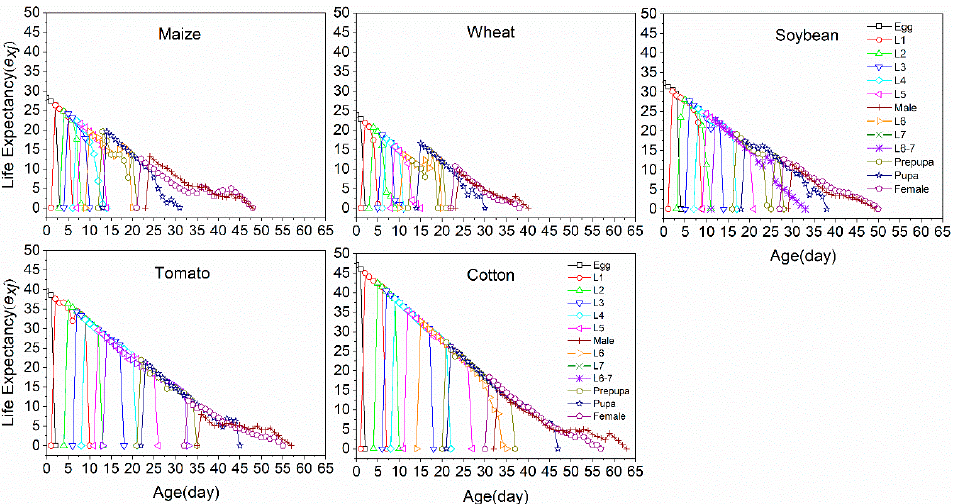
Figure 4. Age-stage specific life expectancy ( e xj ) of S. frugiperda fed on five host crops.